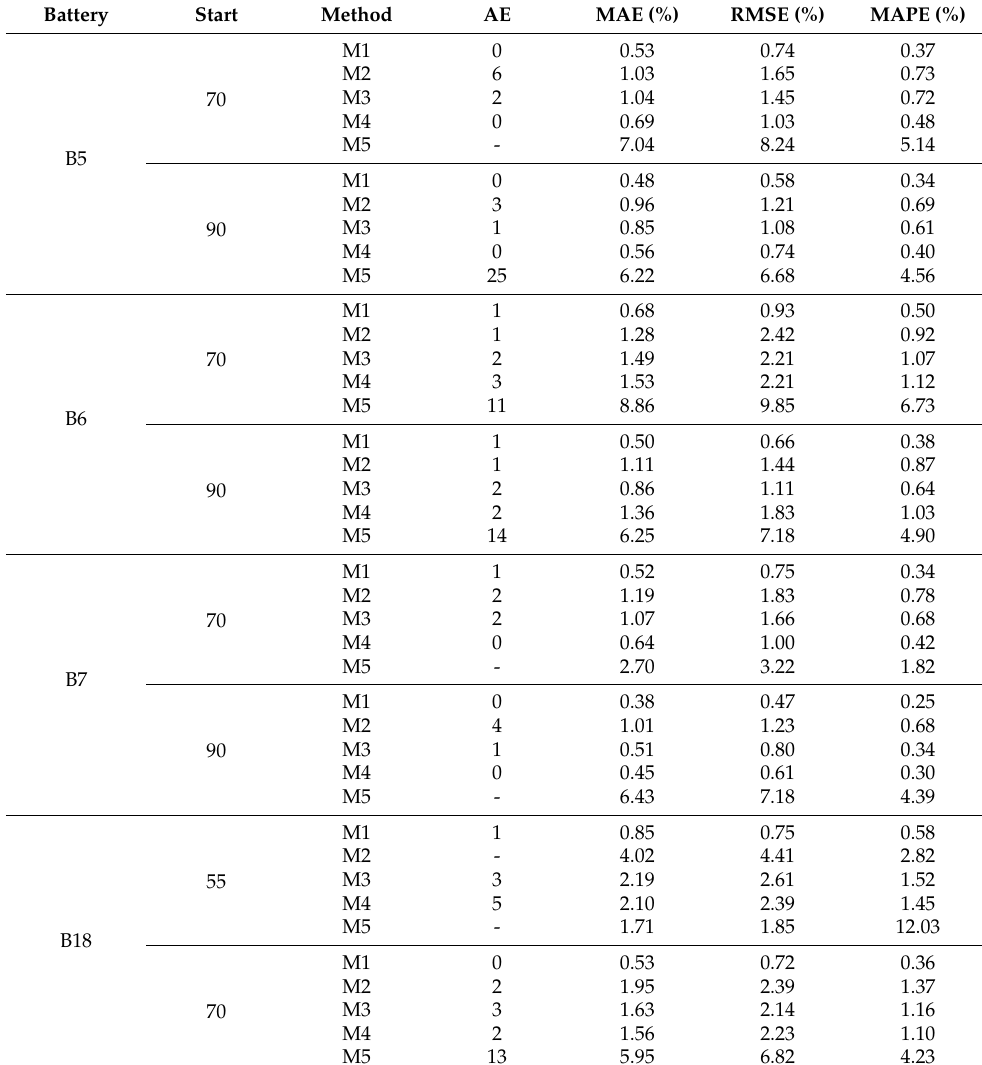
Figure 15. Prediction results of the B18 battery. ( a ) Prediction starting point: 55. ( b ) Prediction starting point: 70. A comparison of the evaluation indicators under different methods is shown in Table 4. Table 4. A comparison of the evaluation indicators.